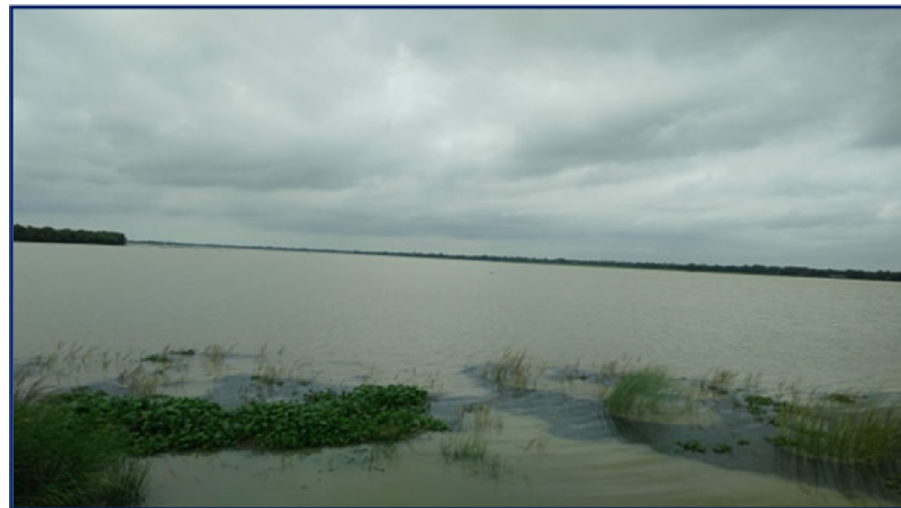
Fig. 5 Beel Kumari at Tanore